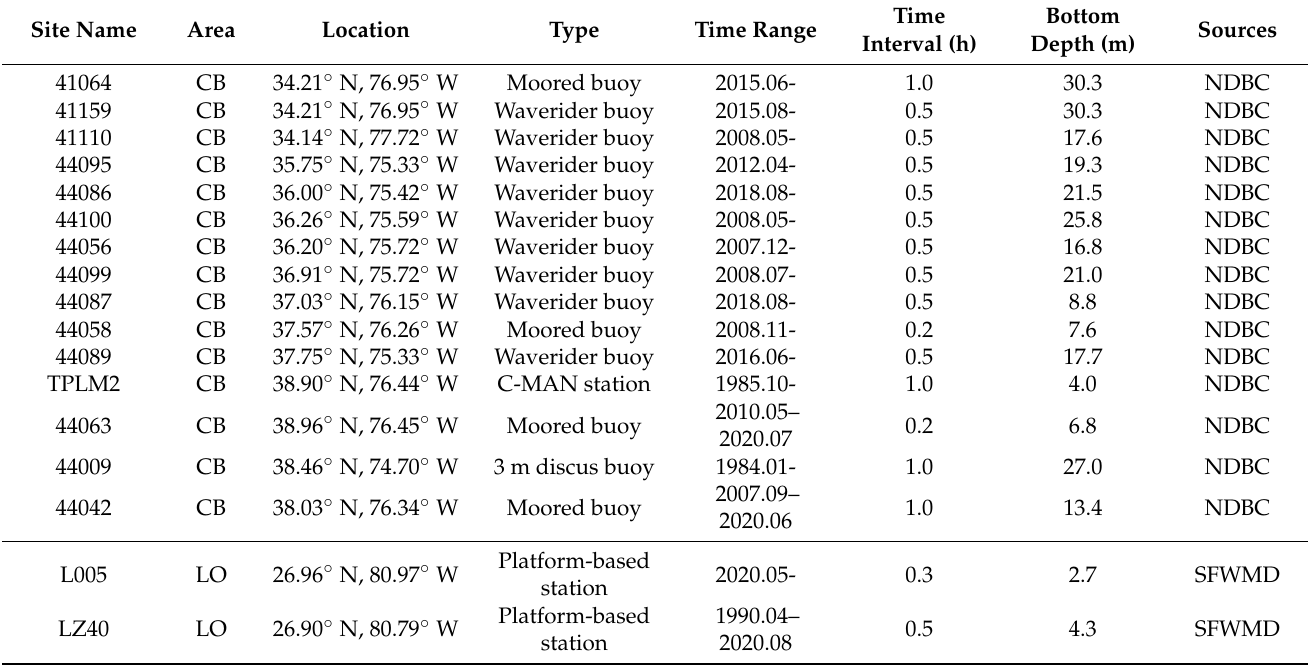
Figure 1. Geographic distribution of the in situ SST measurement sites in three major estuaries and Lake Okeechobee. Detailed information on each site is listed in Table 1. Table 1. Information of sites used in this paper, where the bottom depth was derived from an NOAA bathymetry database (100 m resolution). The exact depths of the thermistors have not been reported but are between 0.5 and 2 m below the water surface.